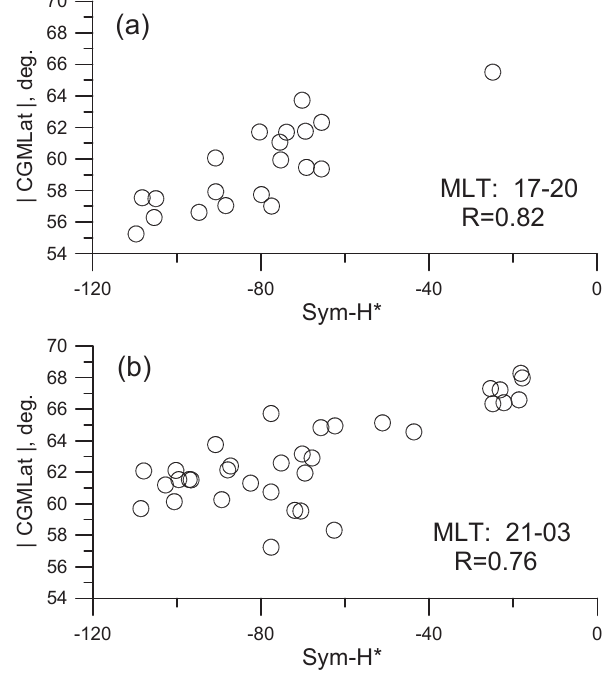
Fig. 9. P2 IB latitude vs. Sym-H ∗ in the 17:00–20:00MLT sector (a) and in the 21:00–03:00MLT sector (b)